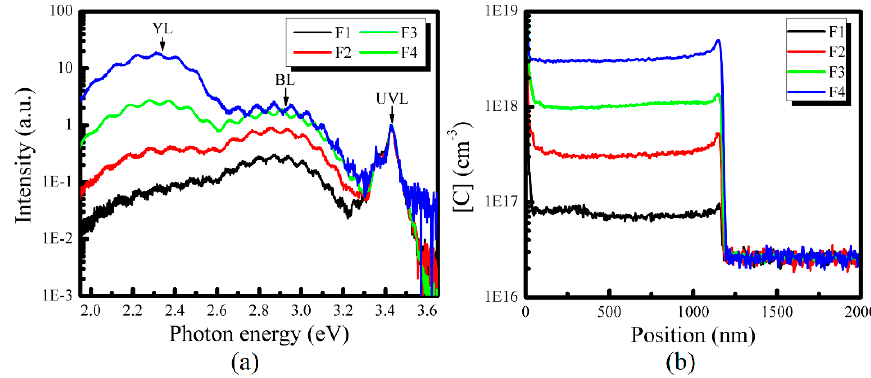
Figure 5. ( a ) Room-temperature PL spectra of u-GaN samples F1–F4 grown under different flow rate of NH 3 , and ( b ) the carbon distribution profile. The arrows indicate the main luminescence bands.